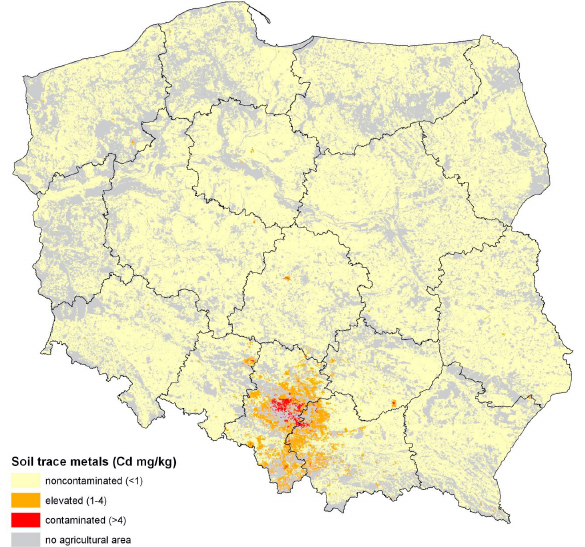
Fig. 1B. Soil contamination with trace metals (cadmium) in Poland. According to national regulations the threshold for Cd content in agricultural soils is 4 mg kg -1 . Above this level the soils should be subjected to remediation